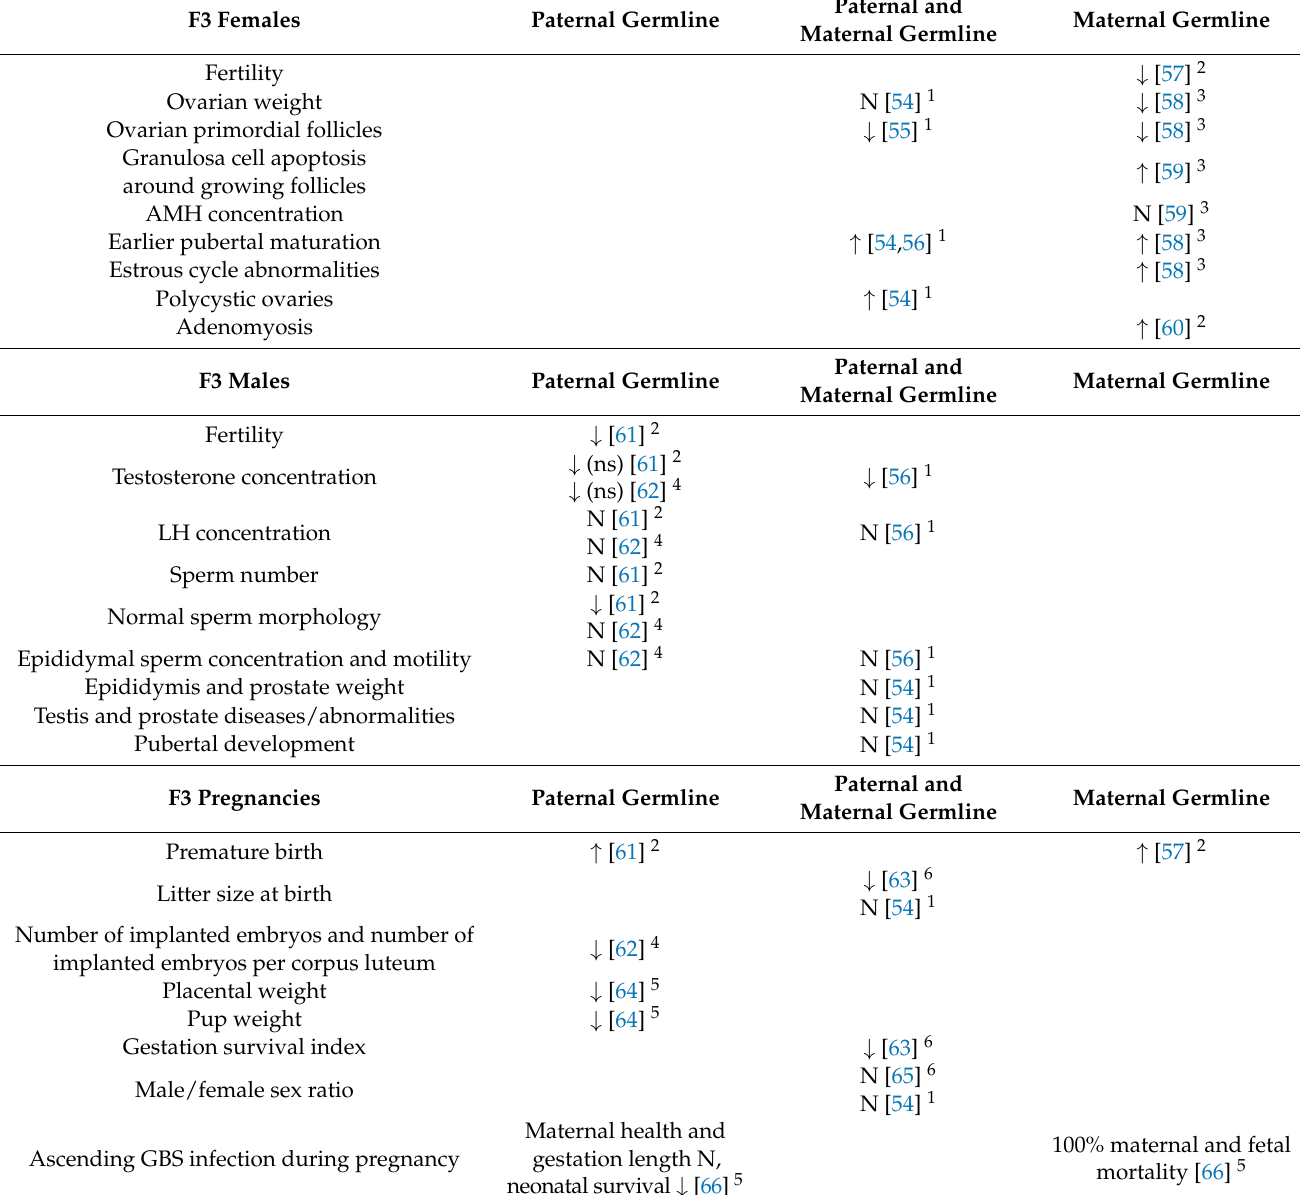
Table 1. TCDD transgenerational effects on the female and male reproductive health and pregnancy outcomes in rodent experimental